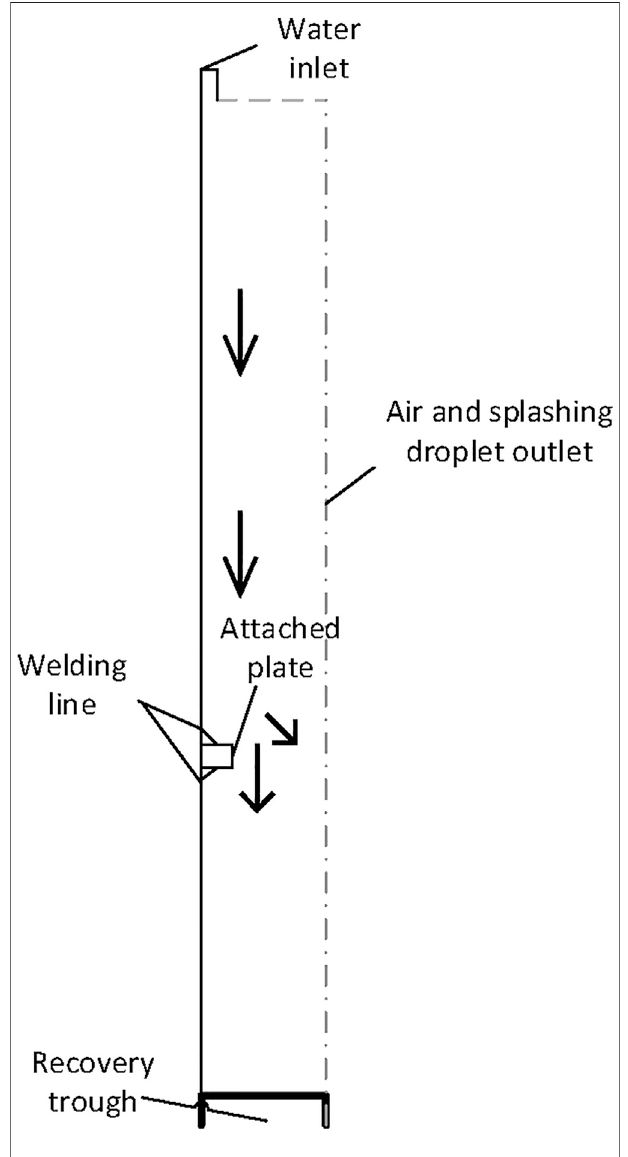
FIGURE 4 | Side view of the 3-D model.